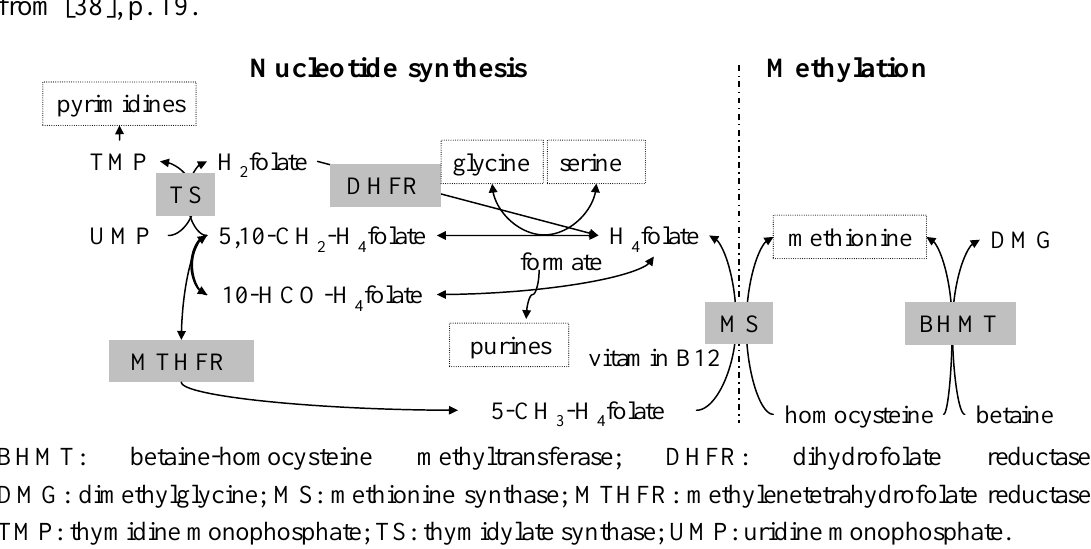
Figure 1. Role of folate in nucleotide synthesis and the methylation cycle (adapted from [37]). Enzymes are shaded and their end-products marked with boxes. Adapted from [38], p.